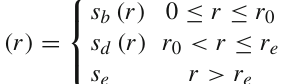
Fig. 8 The left-hand side graphic shows the calculated shape of NGC 3198, and the right-hand side the normalized gravitational potential and its radial derivative along the equatorial plane. The vertical lines in both